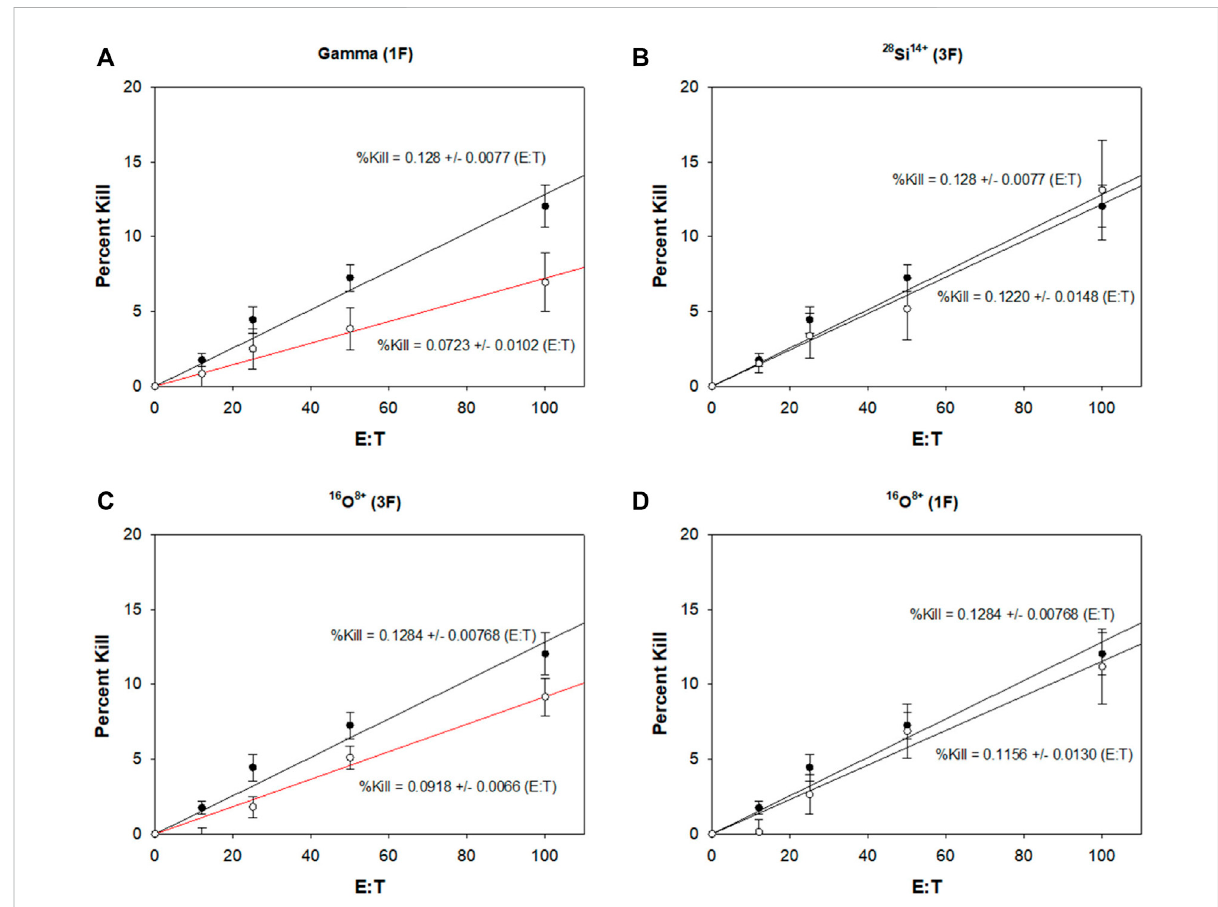
FIGURE 4 Effects of heavy ion exposure on NK cell cytotoxic function 1 – 1.5 yr after irradiation of 10-month old mice. Unirradiated controls ( shown in each plot. (A) 150-cGy gamma rays given in a single fraction [Gamma (1F), n = 6], (B) 40-cGy 28 Si 14+ given in three fractions [ 28 Si 14+ (3F), n = 6], (C) 40-cGy 16 O 8+ givenin threefractions[ 16 O 8+ (3F), n = 12], and (D) 40-cGy 16 O 8+ given as asingle fraction ( 16 O 8+ (1F), n =12). Linear leastsquares fi ts to the data are indicated by the solid lines. The slopes and their standard error are provided for each fi t. Signi fi cance relative to controls is denotedbytheredlinesfor p < 0.05.Bothgamma(1F)and 16 O 8+ (3F)treatmentgroupsdemonstrateddecreasedNKcytotoxicfunctioncomparedto control. Error bars are standard error of the